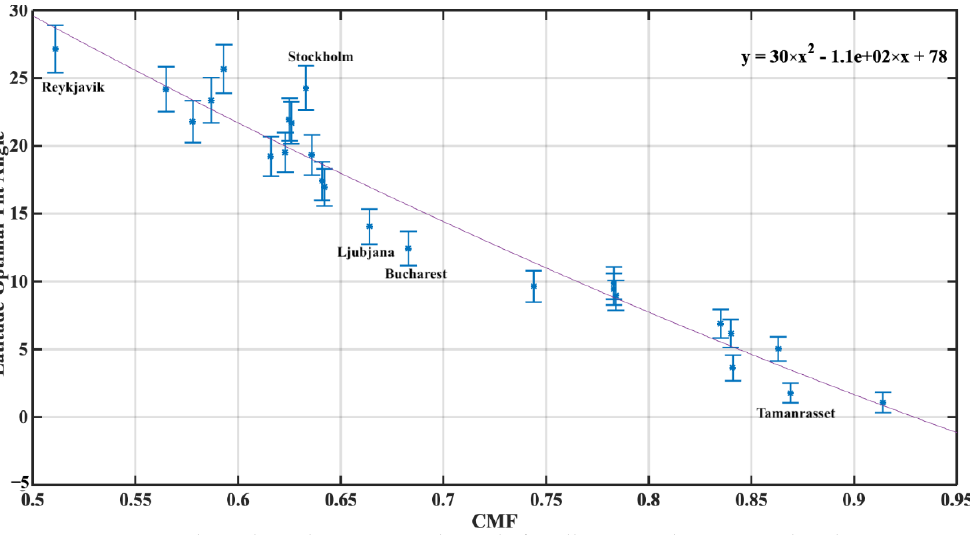
Figure 6. Optimum tilt angle with 1 σ against latitude for all cities and corresponding linear regres- sion.